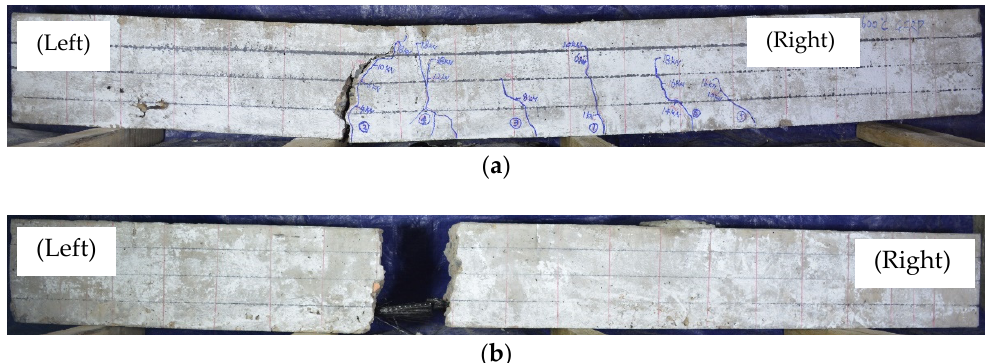
Figure 5. Two kinds of typical failure modes of tested concrete beams: ( a ) GFRP rupture (e.g., G-600); ( b ) CFRP debonding (e.g., C-600).